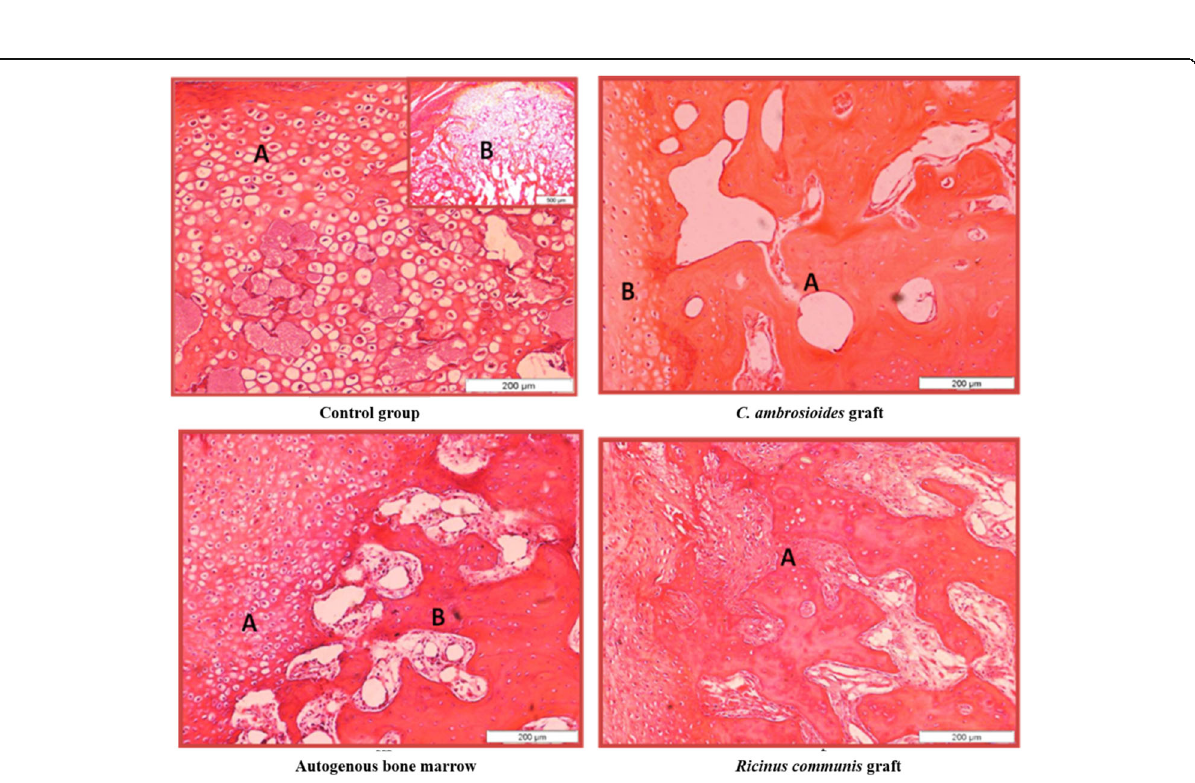
Fig. 6 Effect of lyophilized aqueous Chenopodium ambrosioides extract on bone formation 30 days after application. Histology photomicrographs of bone remodeling in a complete diaphyseal fracture of the radius of rabbits. Control group: ( a ) massive presence of chondrocytes and ( b ) predominance of cartilaginous tissue. C. ambrosioides graft: ( a ) presence of immature bone and ( b ) cartilaginous tissue. Autogenous bone marrow: ( a ) cartilaginous tissue and ( b ) immature bone. Ricinus communis graft: ( a ) chondrocytes and bone remodeling. HE staining (200 μ m and 500 μ